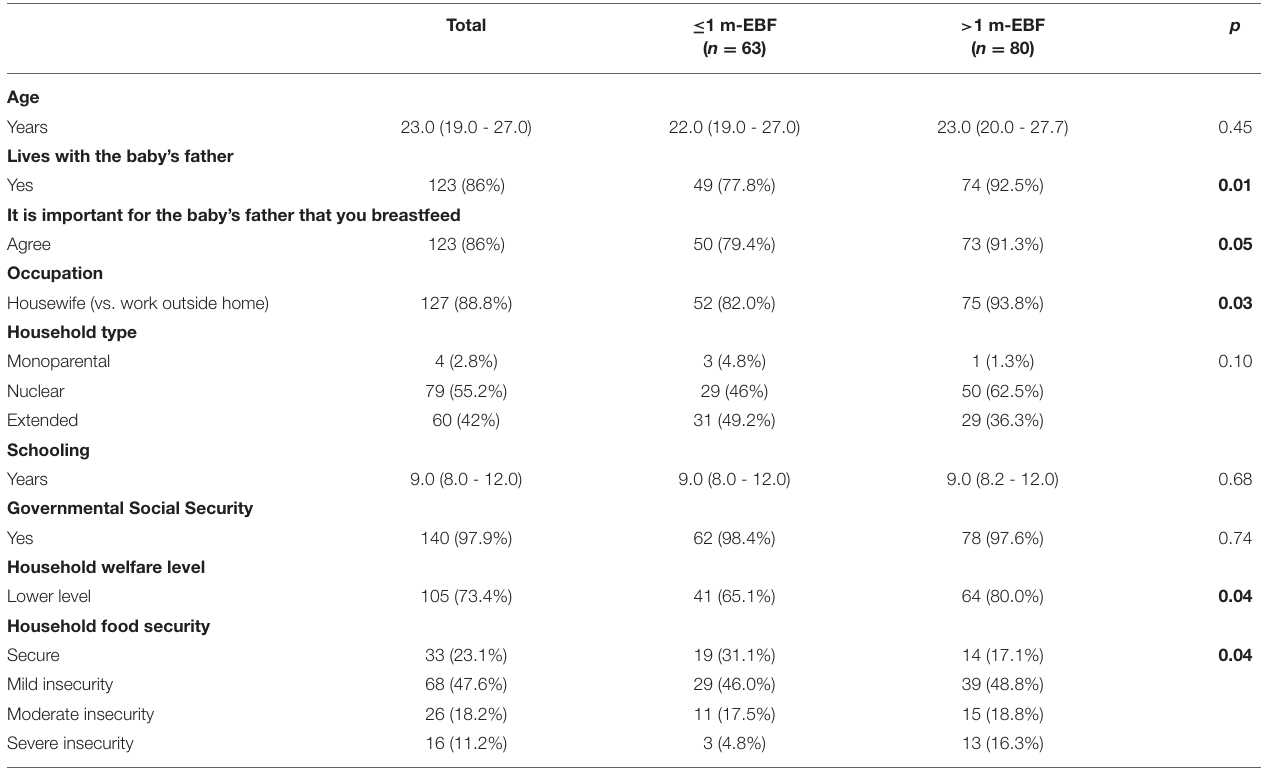
TABLE 1 | Sociodemographic characteristics.